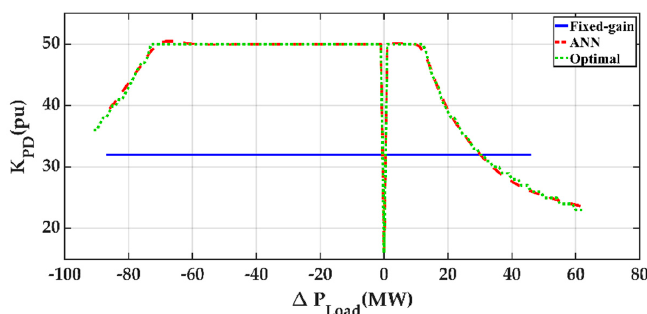
Figure 10. Droop gain K PD from the ANN-based controller, optimal controller, and fixed-gain controller (wind penetration = 29.4% and V W = 11 m/s) under different load disturbances.